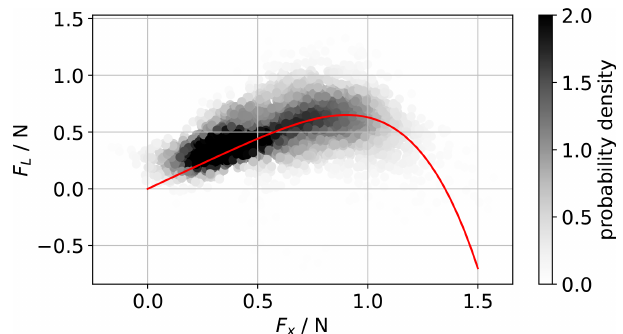
Figure 5. Calibration curve of thrust generated by lift F L versus drag force in x direction F x in the body frame. The greyscale rep- resents the probability of occurrence.